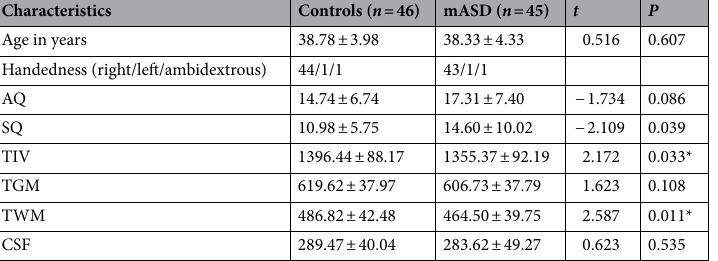
Table 1. Participant characteristics. Means ± standard deviations and accompanying statistics (two-sided t -tests) for participant characteristics. There were no significant differences in age, AQ score, or SQ score between the control and mASD groups (two-sample t -tests with FDR multiple corrections). TIVs were significantly different between the control and mASD groups. * P < 0.05. AQ autism spectrum quotient, mASD mothers of individuals with autism spectrum disorder, SQ systemizing quotient, TIV total intracranial volume, TGM total grey matter volume, TWM total white matter volume, CSF cerebrospinal fluid, FDR false discovery